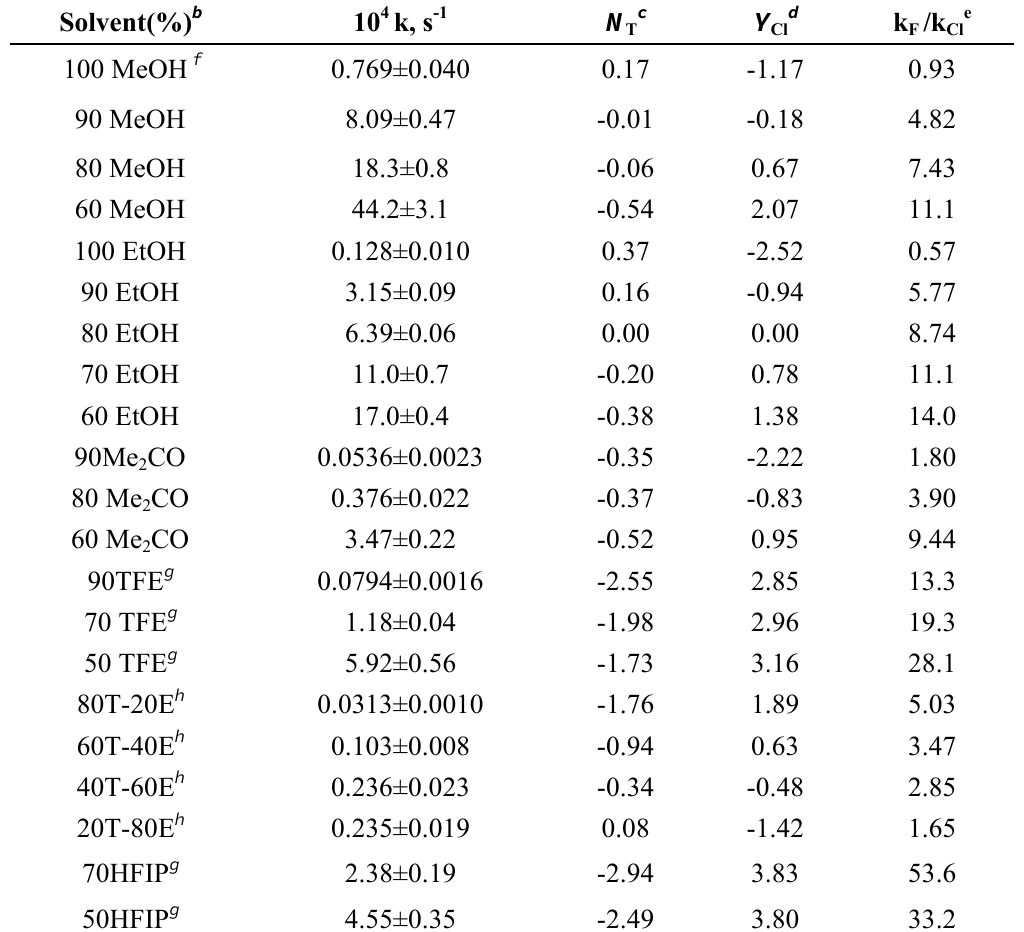
Table 1. Specific rates of solvolysis (with standard deviation) of ethyl fluoroformate a in pure and binary solvents at 24.2 °C together with the appropriate solvent nucleophilicity ) and solvent ionizing power ( Y ) values and the specific rate ratio relative to ethyl ( N T Cl chloroformate ( k / k F Cl